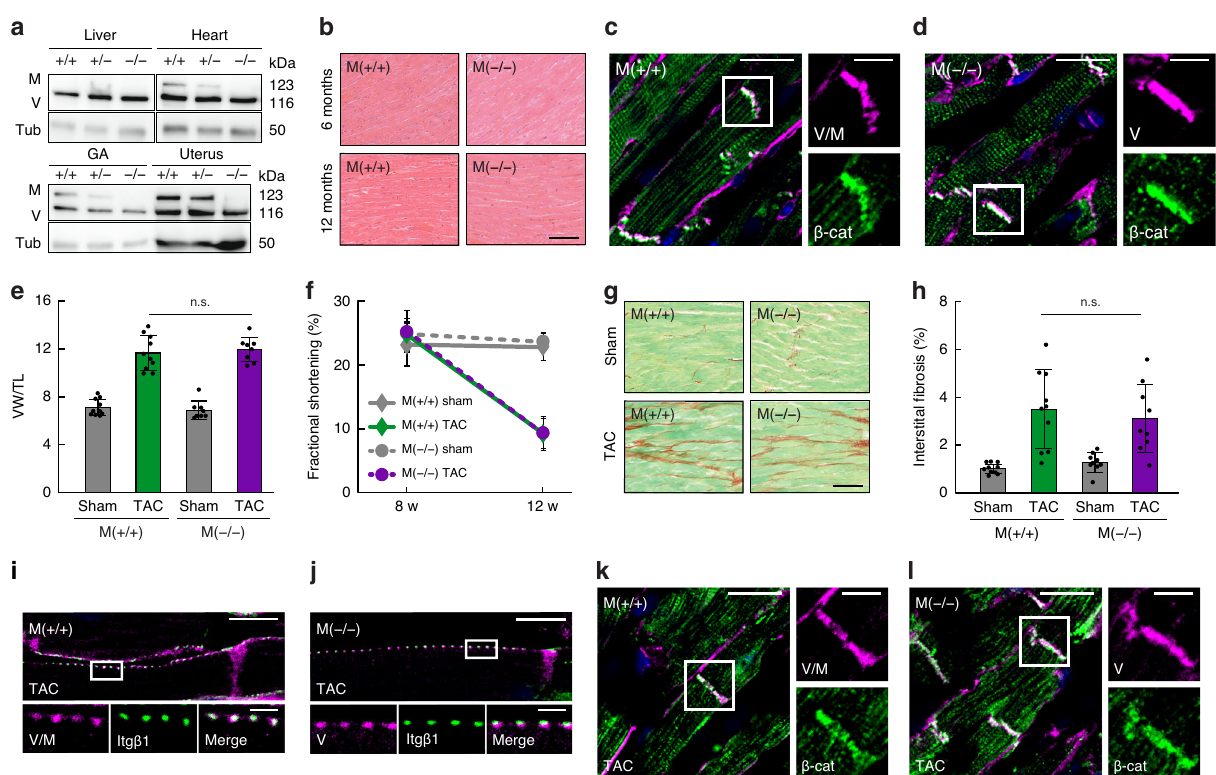
Fig. 4 Metavinculin knockout mice display a normal hypertrophic response upon transverse aortic constriction (TAC). a Western blot analysis of tissue lysates from 6-month-old mice shows complete loss of metavinculin in knockout M ( − / − ) and ~50% reduction of expression in heterozygous M ( + / − ) animals, compared to wild-type M ( + / + ) littermates. (GA: gastrocnemius muscle, V: vinculin, M: metavinculin, Tub: tubulin). b Histological analysis of M ( + / + ) and M ( − / − ) heart tissue of 6- and 13-month-old mice indicates normal morphology of the cardiac muscle. Scale bar: 40 µ m. c , d Representative immunohistochemistry of ventricular tissue from 13-month-old M ( + / + ) and M ( − / − ) mice, respectively, reveals unchanged intercalated disk (ICD) structures as indicated by β -catenin ( β -cat) and (meta)vinculin (V/M) staining. Nuclei are visualized with DAPI (blue). Scale bar: 20 µ m, in zoom: 10 µ m. e Heart weight analysis of sham- or TAC-operated mice, expressed as the ventricular weight (VW) normalized to tibia length (TL) shows no difference between M ( + / + ) and M ( − / − ) mice ( n = 10, 10, 9, 9 mice). The bar chart shows the mean values±SD. f Echocardiography assessment shows the expected decrease in fractional shortening in TAC-operated animals; the effect is highly similar in M ( + / + ) and M ( − / − ) mice. ( n = 10, 9, 9, 7 mice). The line chart shows mean values±SD. g Representative images of Sirius Red/Fast Green-stained myocardium show anticipated tissue fi brosis in each group of TAC-operated animals. Scale bar: 40 µ m. h Quantitative analysis of interstitial fi brosis reveals a normal tissue response in metavinculin-de fi cient mice. ( n = 10, 10, 9, 9 mice). i , j Representative immunohistochemistry of ventricular tissues from 3-month-old M ( + / + ) and M ( − / − ) TAC-operated mice, respectively. Costameres are visualized with β 1 integrin (Itg β 1) and (meta)vinculin (V/M) staining. Scale bar: 10 µ m, in zoom: 2 µ m. k , l Representative immunohistochemistry of ventricular tissues from 3-month-old M ( + / + ) and M ( − / − ) TAC-operated mice shows normal ICD structures as indicated by β -catenin ( β -cat) and (meta)vinculin (V/M) staining. Nuclei are visualized with DAPI (blue). Scale bar: 20 µ m, in zoom: 10 µ m. Two-sided ANOVA followed by Sidak ’ s test: n.s. (not signi fi cant) p ≥ 0.05. Expected molecular weight values are indicated (kDa). Source data, exact p values, and uncropped immunoblots with protein markers are provided in the Source Data fi